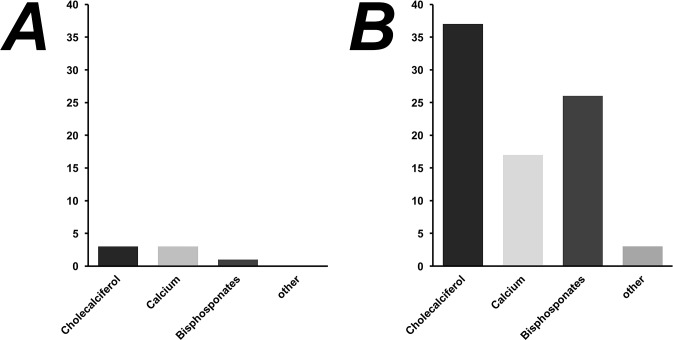
Overall prescribed anti-osteoporotic medication in (A) male (B) female patients.